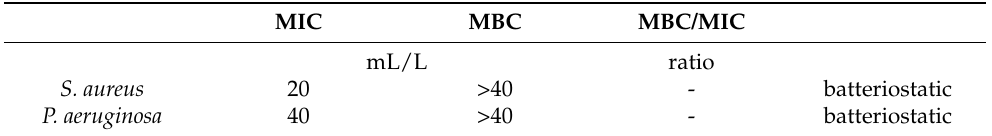
Table 2. Limonene MIC and